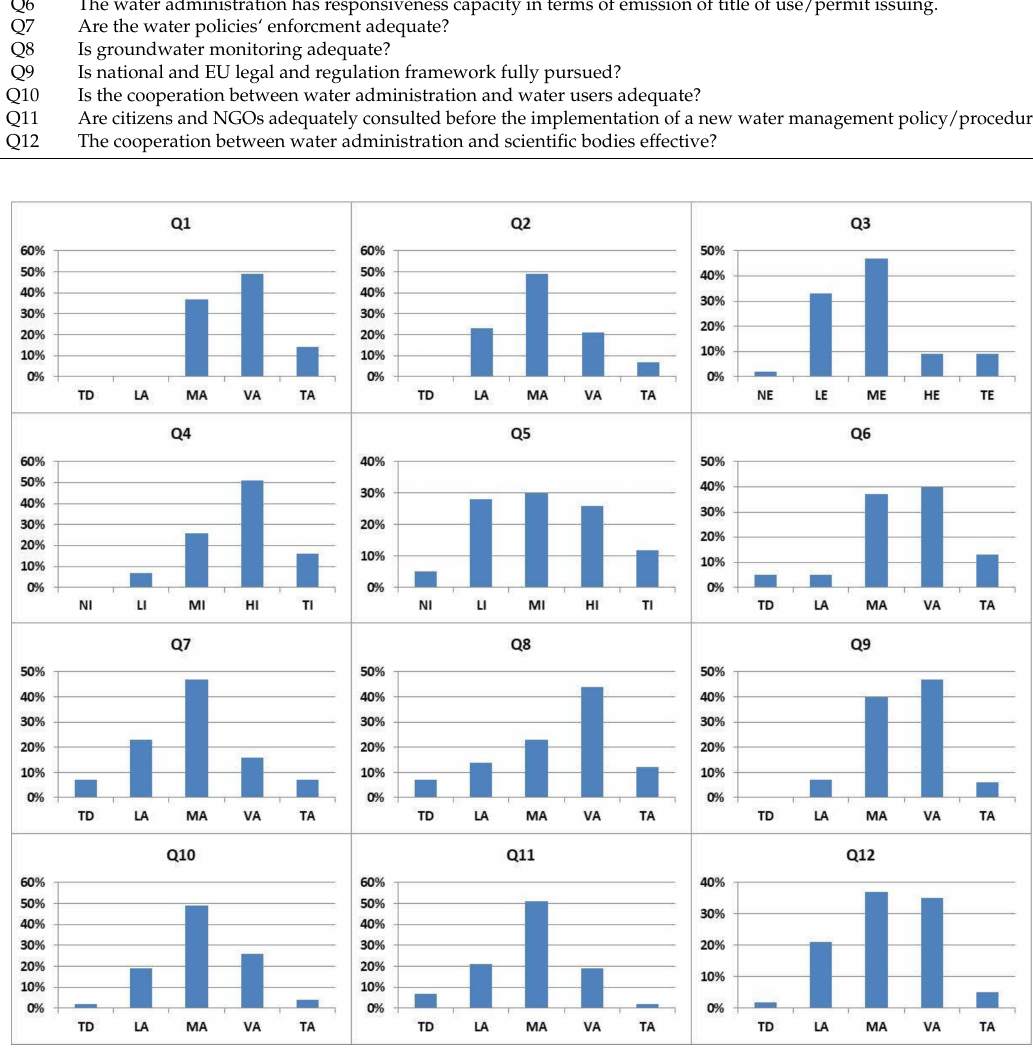
Figure 7. Histograms for the several responses to questions made about groundwater management in the Azores (TD: totally disagree; LA: little in agreement; MA: more or less in agreement; VA: very agree; TA: totally agree; NE: non-effective; LE: low effectiveness; ME: more or less effective; HE: highly effective; TE: totally effective; NI: totally non-integrated; LI: limitedly integrated; MI: more or less integrated; HI: highly integrated; TI: totally